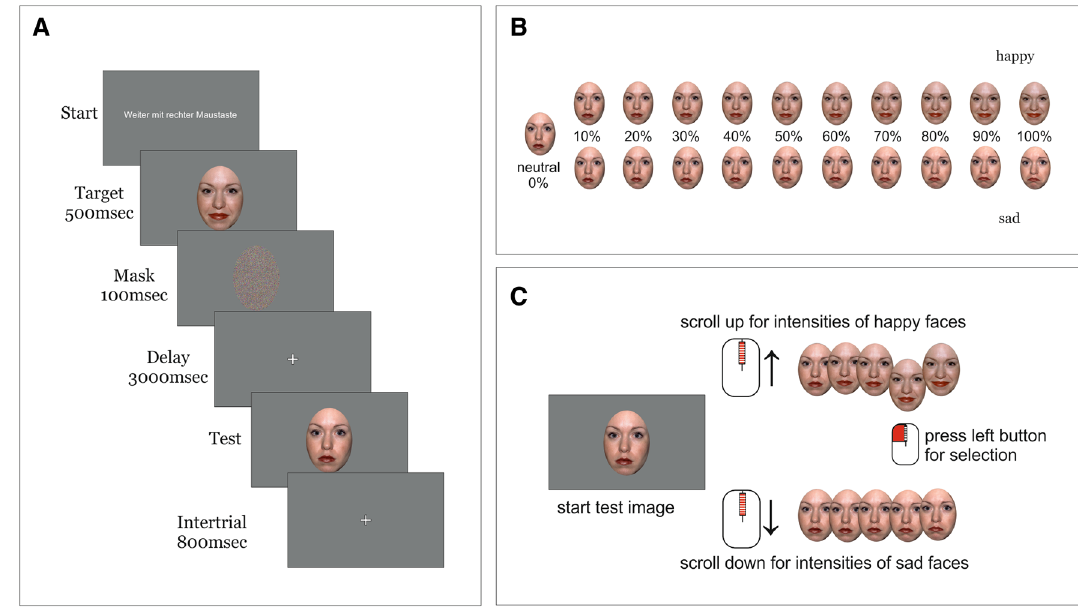
Figure 1. Procedure of the facial emotion WM task. On each trial, participants were asked to encode a target face with an emotional expression (sad or happy) of a certain intensity. After a delay, participants used a mouse to adjust the expression to match the emotion and intensity of the face in memory. ( A ) Trial example. Each trial began with a starting image, presented until participants press the right mouse button. The target image was displayed for 500 ms followed by a mask image of 100 ms. After a delay of 3000 ms the test image was shown and participants had to respond. After the response or after 11 s a fixation cross appeared for 800 ms before the next trial started. ( B ) Target Image. The target image was either a happy or a sad emotional face at one of 11 intensity steps (neutral, 10, 20, 30, 40, 50, 60, 70, 80, 90, 100% sad or happy). ( C ) Test Image. The test image always started with a neutral face. By using the mouse wheel, participant could adjust the remembered emotion and the intensity. Scrolling the mouse wheel changed the intensity of the emotional face continuously in steps of 1%. By pressing the left mouse button, the participant made their final